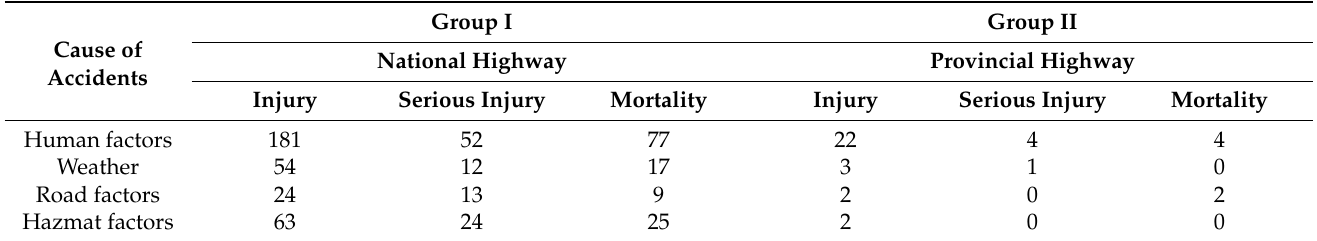
Table 1. The number of accidents by cause of casualties and road